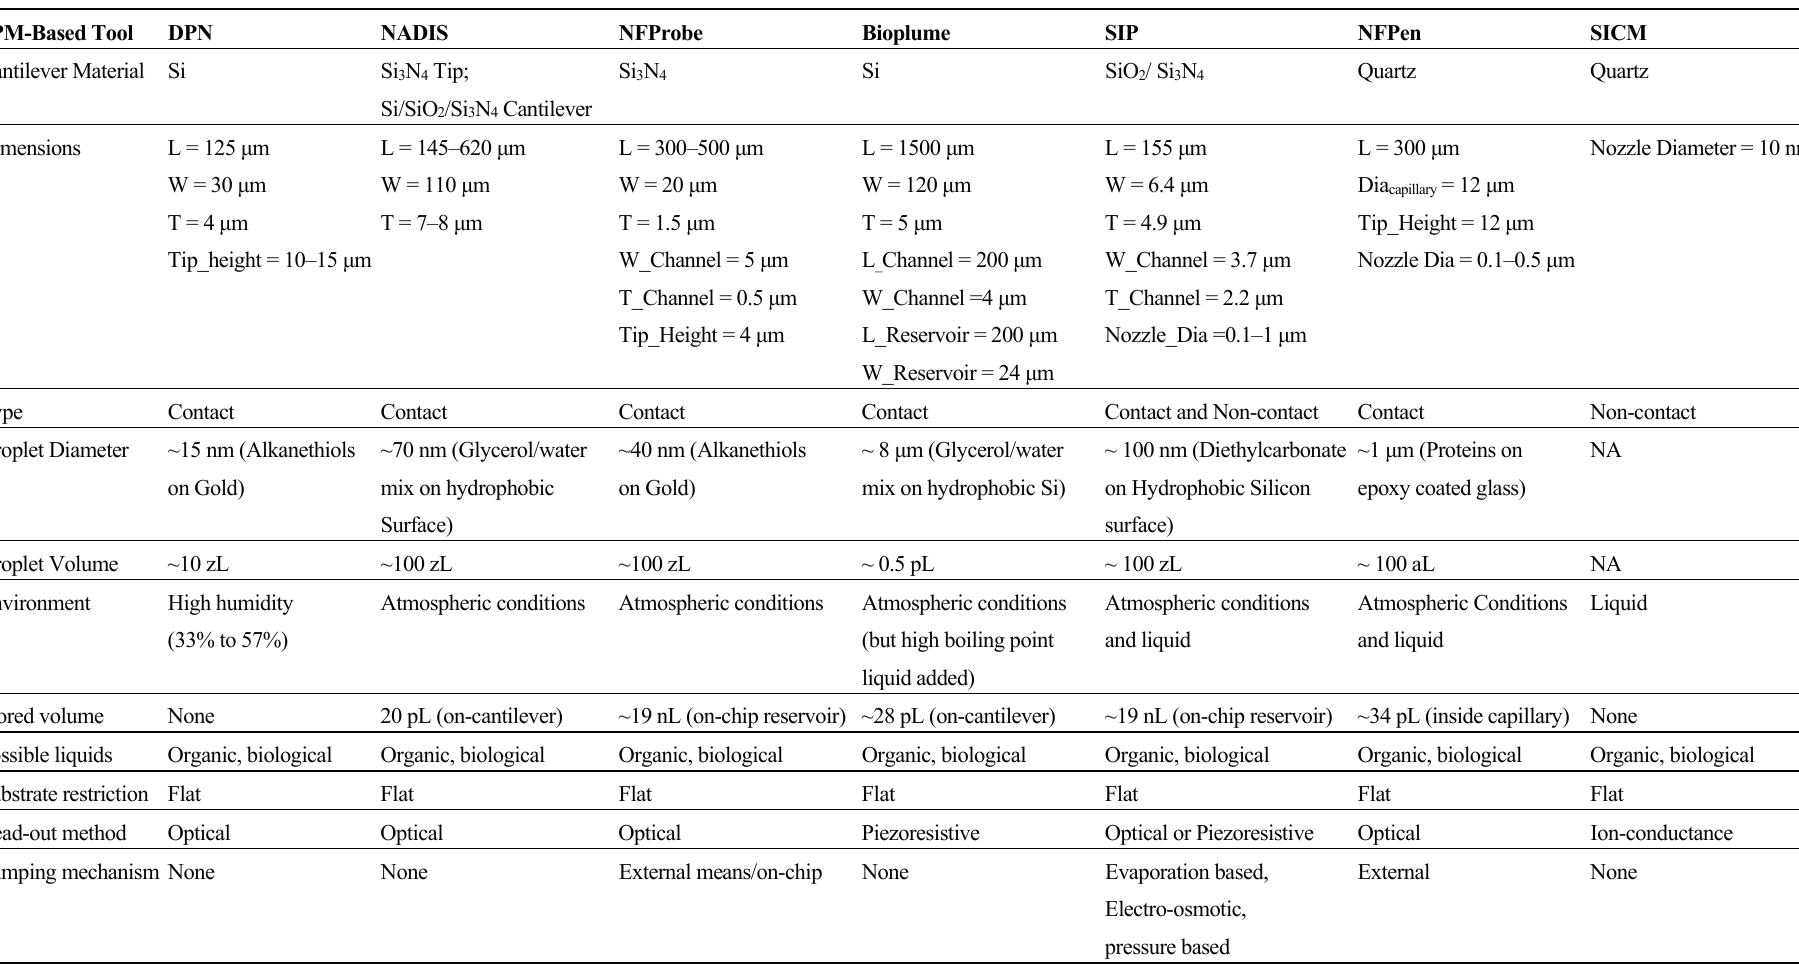
Table 3. Comparison of various characteristics of fluid handling